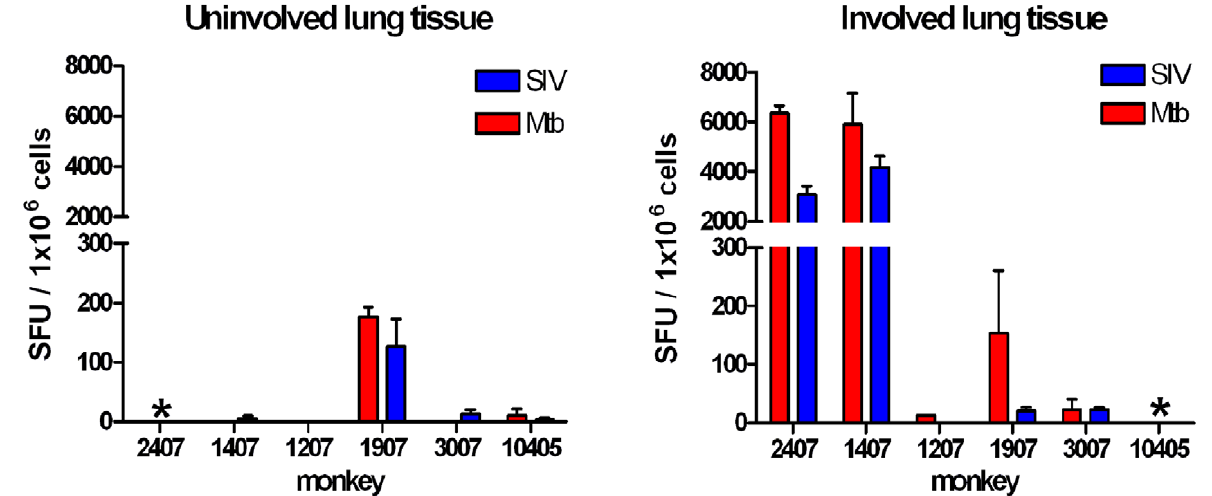
Figure 6. Antigen specific T cells in involved and uninvolved tissue of co-infected monkeys. Tissue homogenates were isolated from the granulomatous (involved) or tissues without grossly present granulomas (uninvolved) in lung. Monkeys not represented because too few cells were recovered from tissues at necropsy are indicated by asterisks.